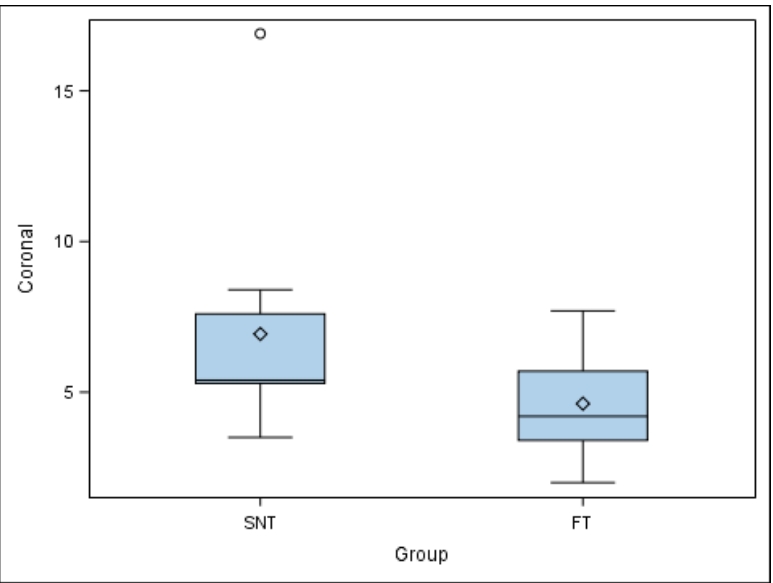
Figure 6. Box plot of the coronal deviation of the autotransplanted teeth. The horizontal line in each box represents the respective median value of the study groups. ◊ : Mean value of the box plots. ◦ : Means and extreme value.